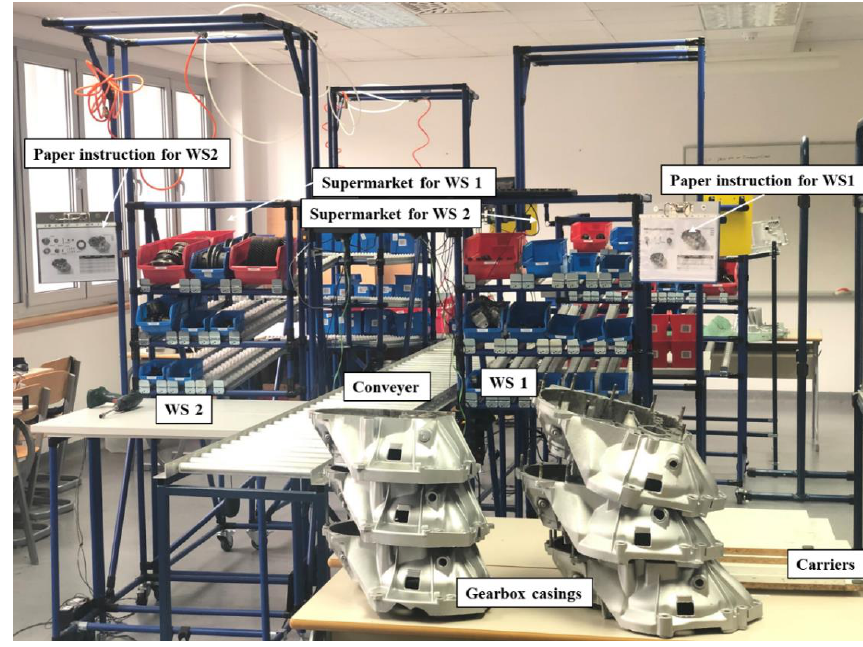
Figure 3. The gearbox assembly line in LLF.